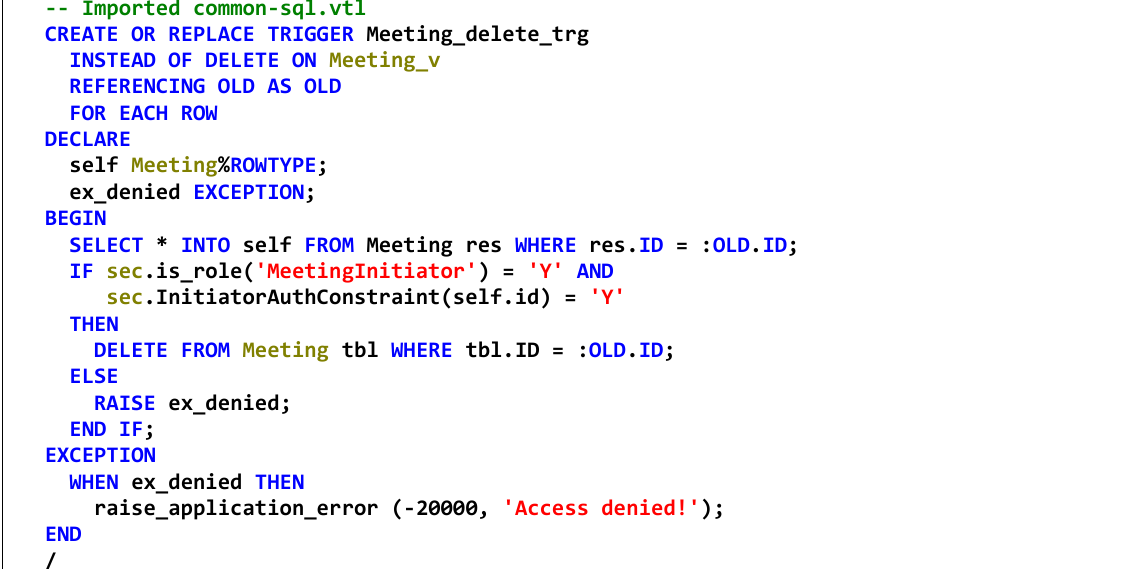
Figure 13. Transformed Delete authorisation constraint